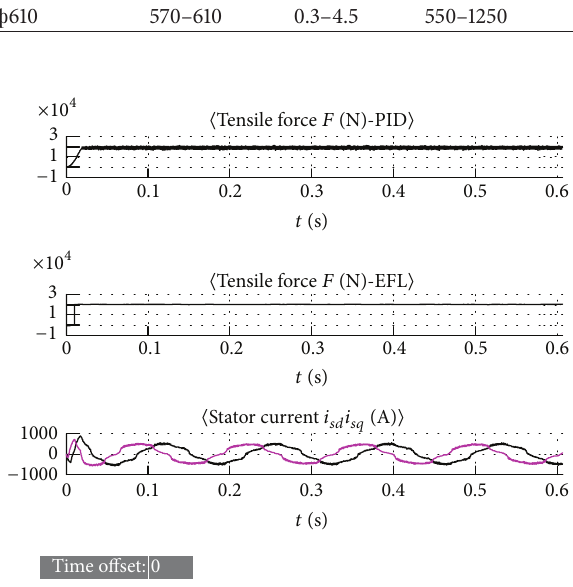
Figure 7: Tension control of the hot rolling